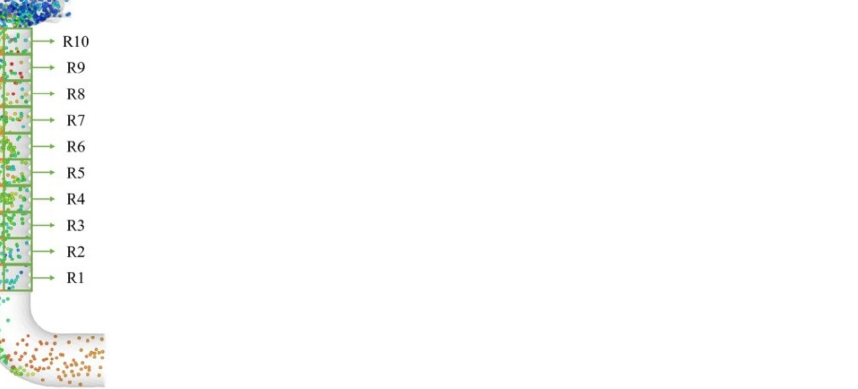
where M Li represents the mass of particles passing through the Li area on the left, and M Ri represents the mass of particles passing through the Ri area on the left.